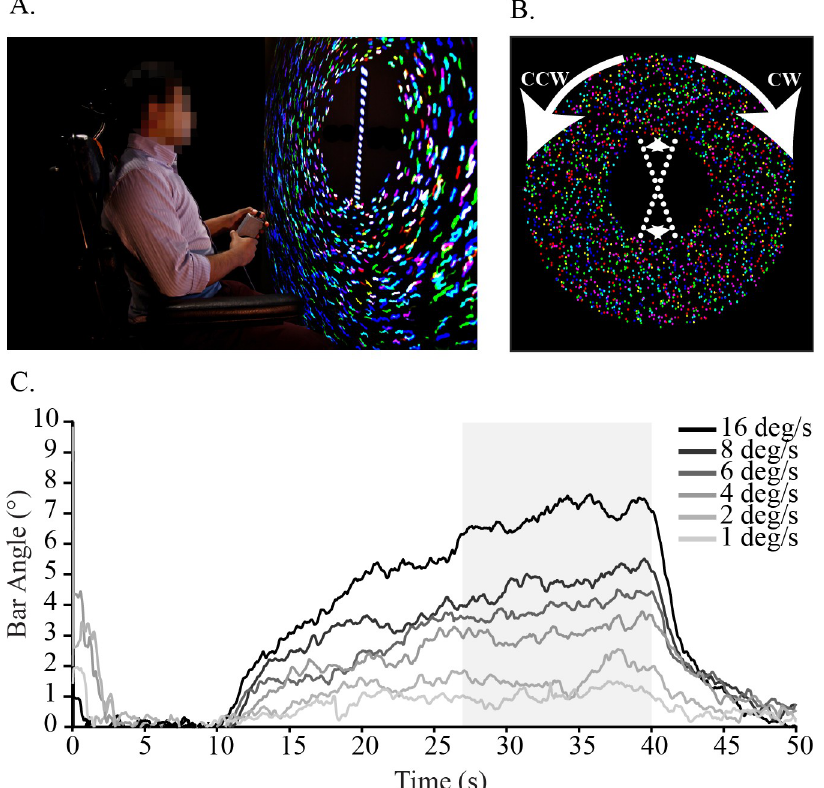
Fig 1. Methods and experimental set up. A . Participants sat in front of an annulus of colored dots B . The dots rotated clockwise (CW) or counter-clockwise (CCW) while participants controlled the angle of a dotted line in the center using a handheld potentiometer. C . Grand means (N = 10) time-course of bar bias for the zero noise conditions at each velocity. Time-period used to estimate mean bar bias during visual motion for each trial was from 27s to 40 seconds (shaded